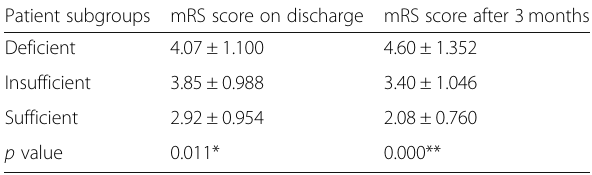
Table 4 Comparison between patient subgroups regarding mean mRS scores on discharge and after 3 months